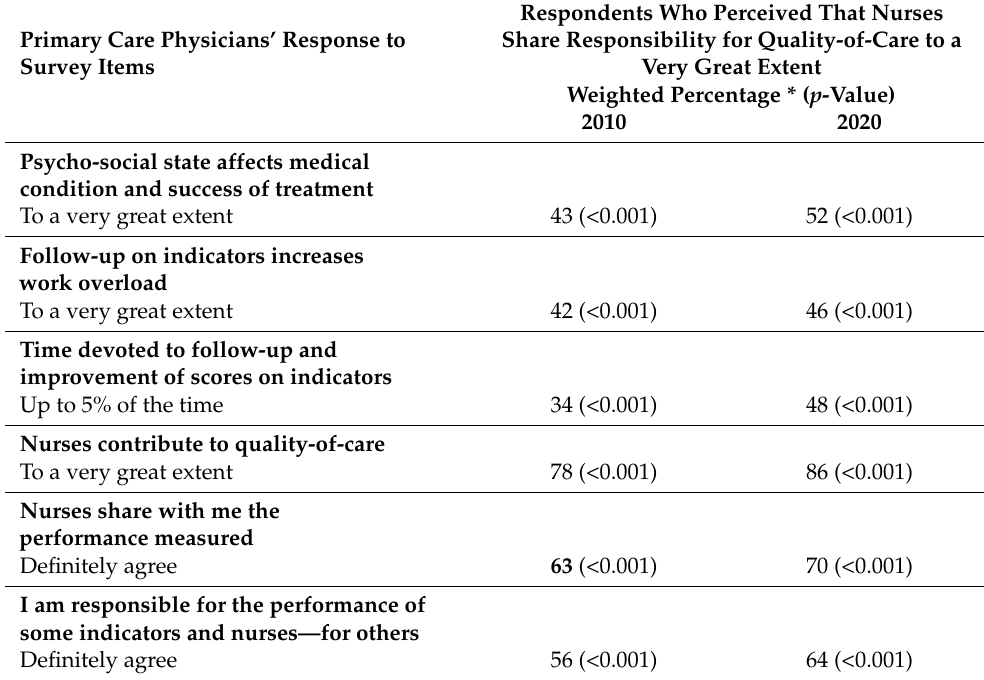
Table 3. Bivariate analysis of the association of the independent variables with physicians’ perceptions on nurses’ shared responsibility for improving quality-of-care by years of study.